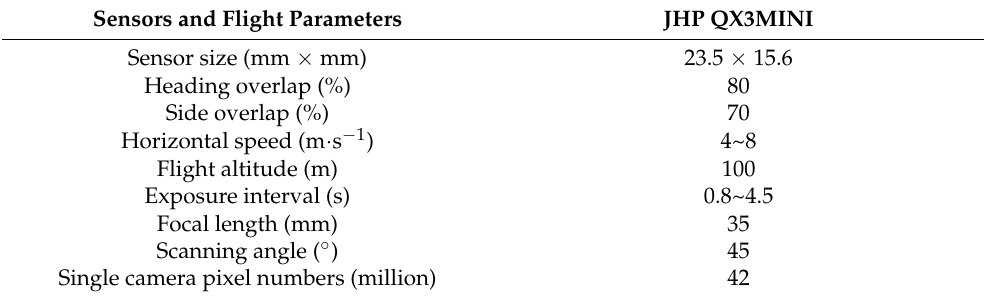
Table 1. Flight and camera parameters of UAV oblique photogrammetry.